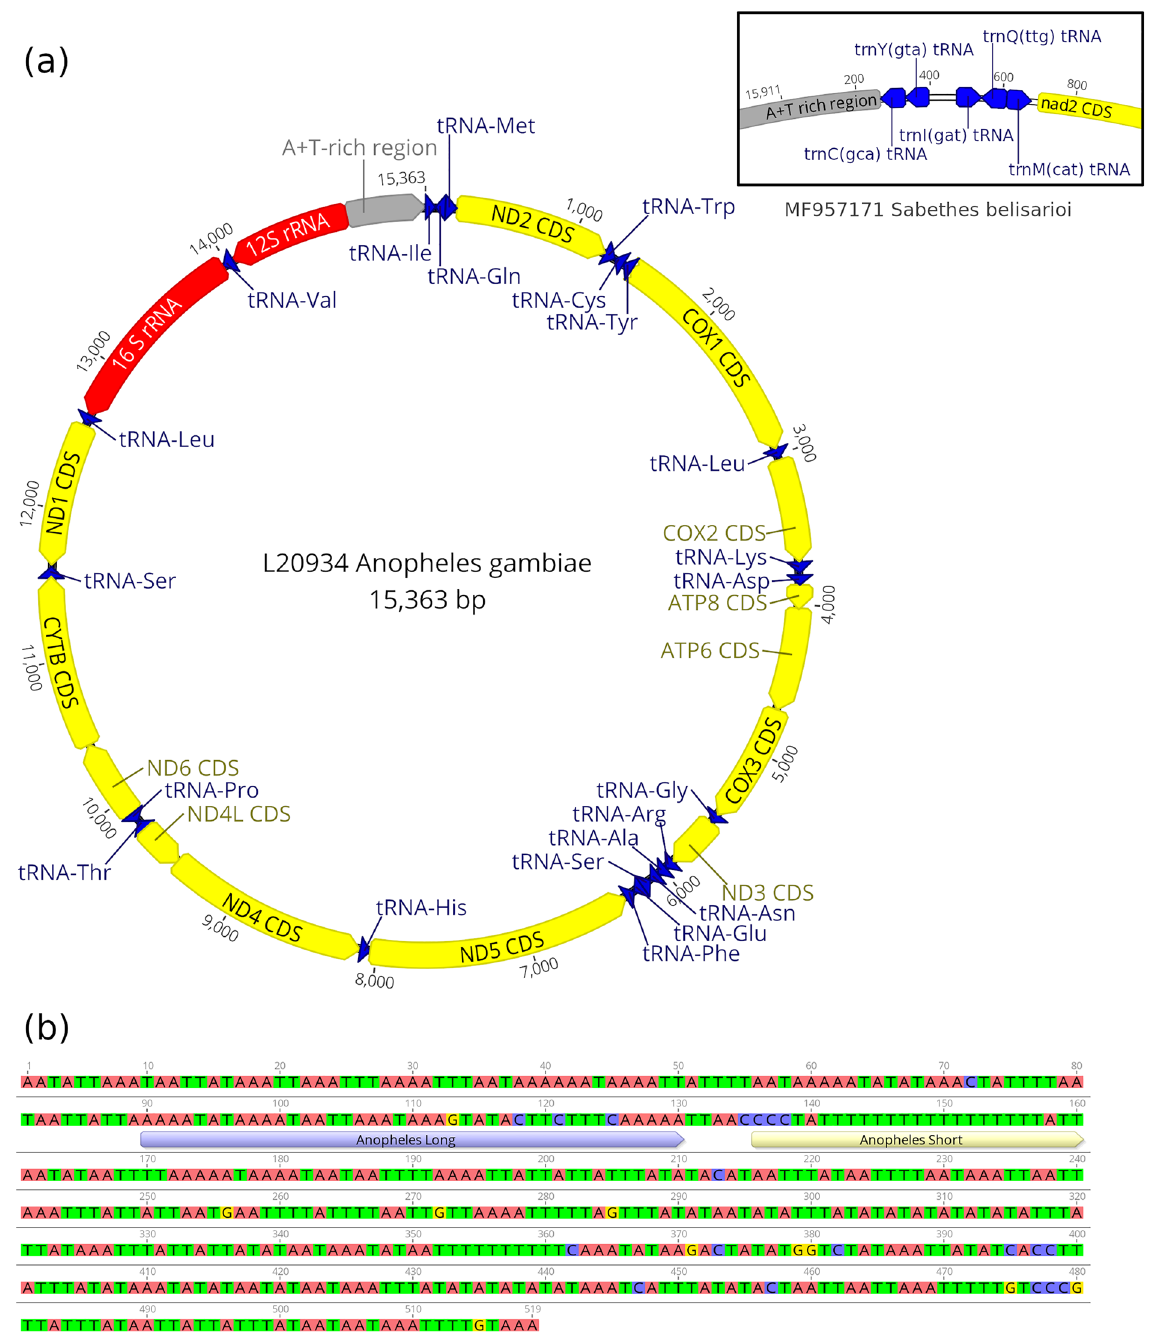
Figure 2. ( a ) Mitochondrial genome of Anopheles gambiae L20934. Yellow regions are the coding sequences of protein coding genes. Red regions are rRNA genes. Blue regions are tRNA genes. Grey region is the control region. Organization of genes is the same in all genera except Sabethes , where the tRNA Cys and tRNA Tyr genes are found in the control region, rather than between the ND2 and COX1 CDS. Gene organization for Sabethes belisarioi MF957171 tRNA bordering the control region is shown in an inset. ( b ) Close up of Anopheles gambiae L20934 control region with motif regions labelled. Generated with Geneious R11.1 (https:// www. genei ous.